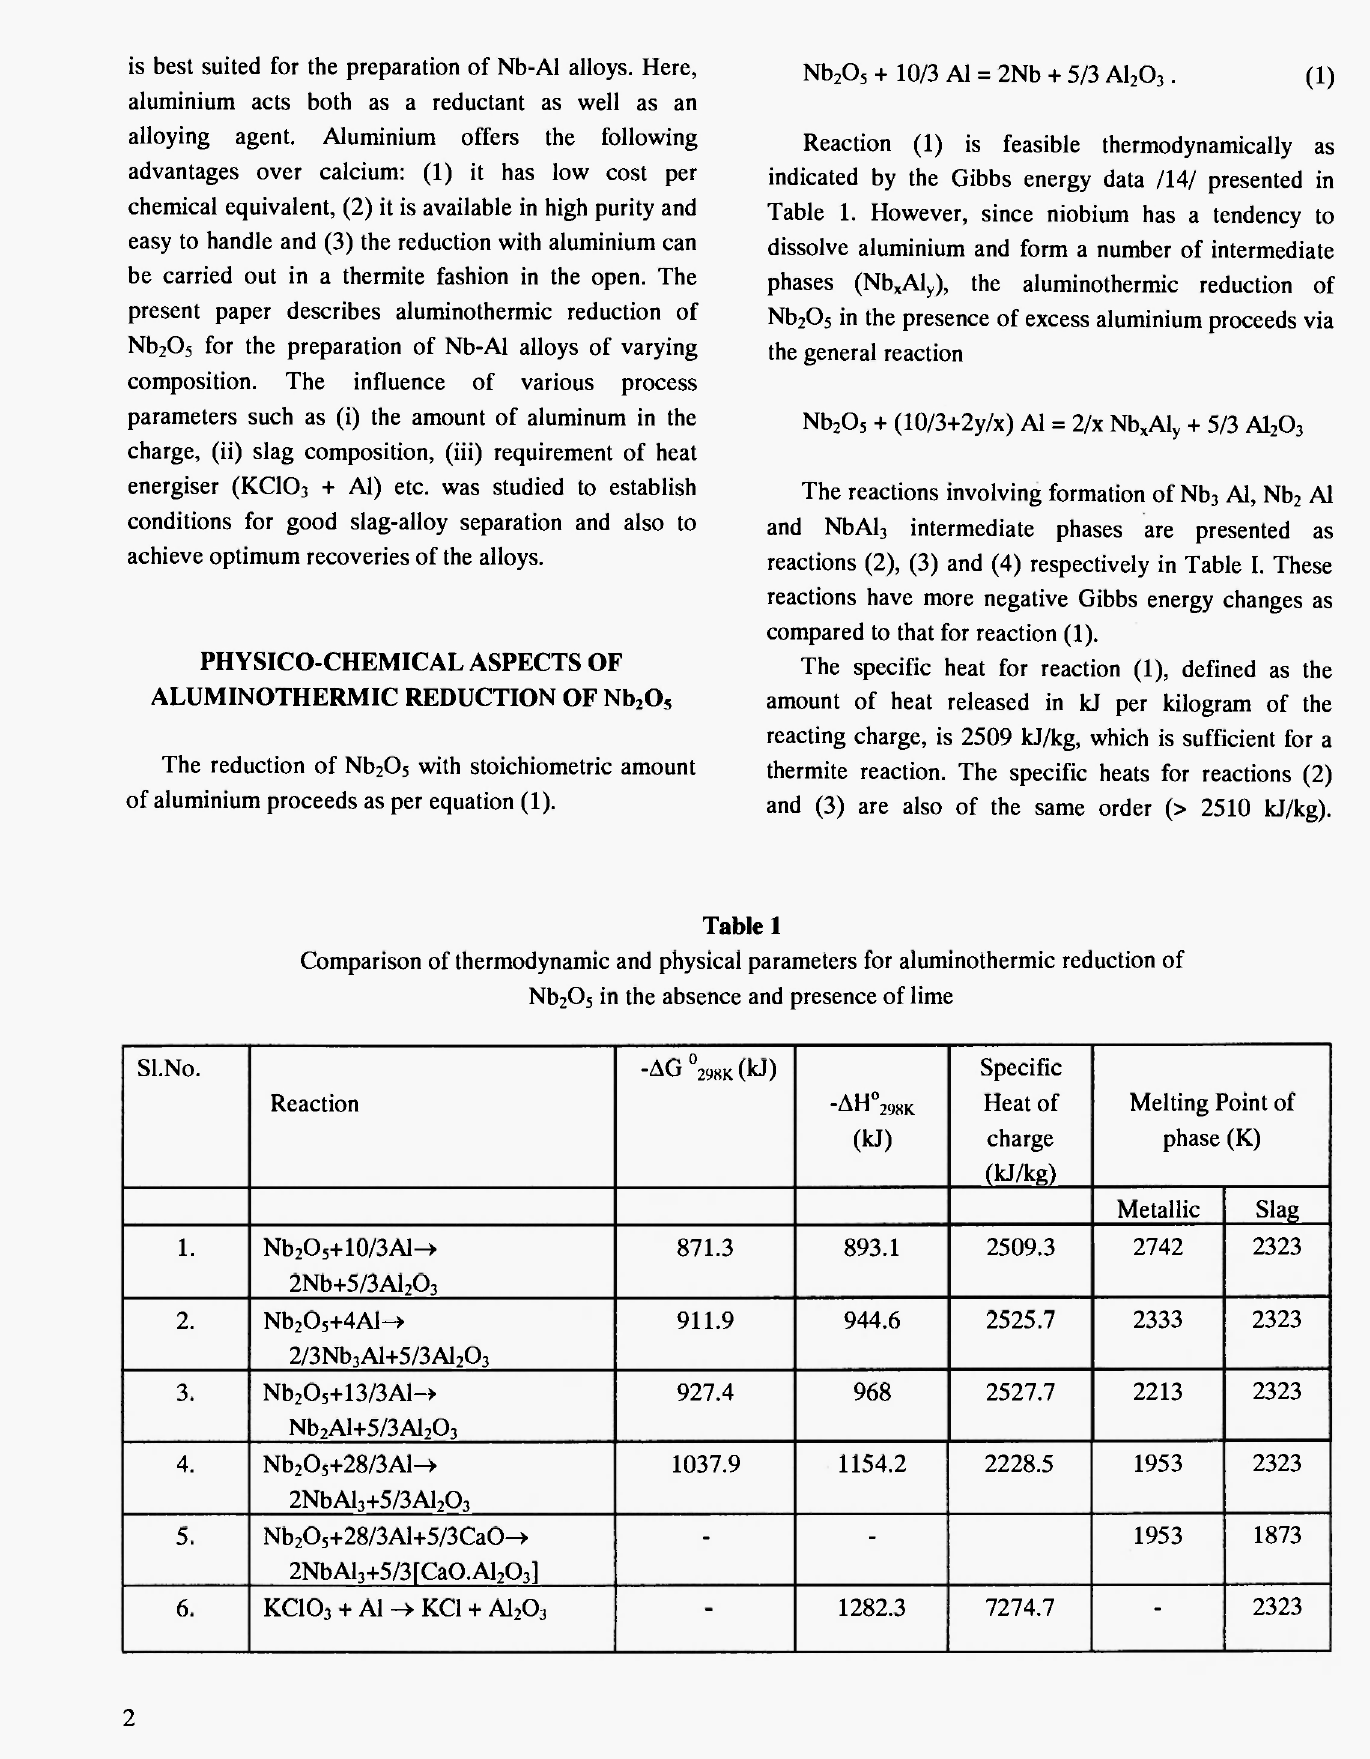
Comparison of thermodynamic and physical parameters for aluminothermic reduction of Nb 2 0 5 in the absence and presence of lime